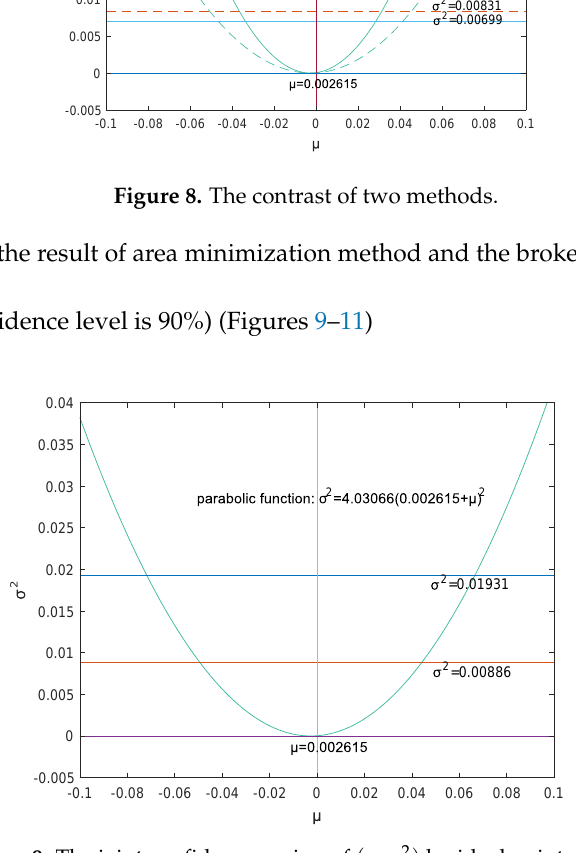
Figure 9. The joint confidence region of ( µ , σ 2 ) by ideal point method.